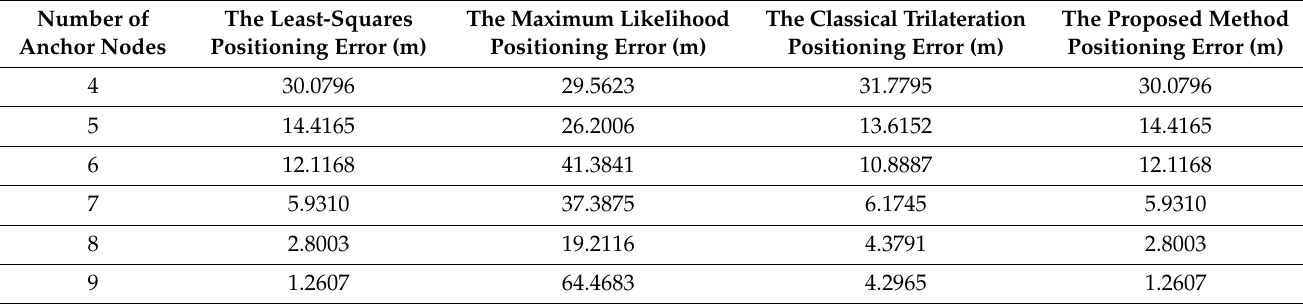
Table 2. Positioning error comparison of five methods.